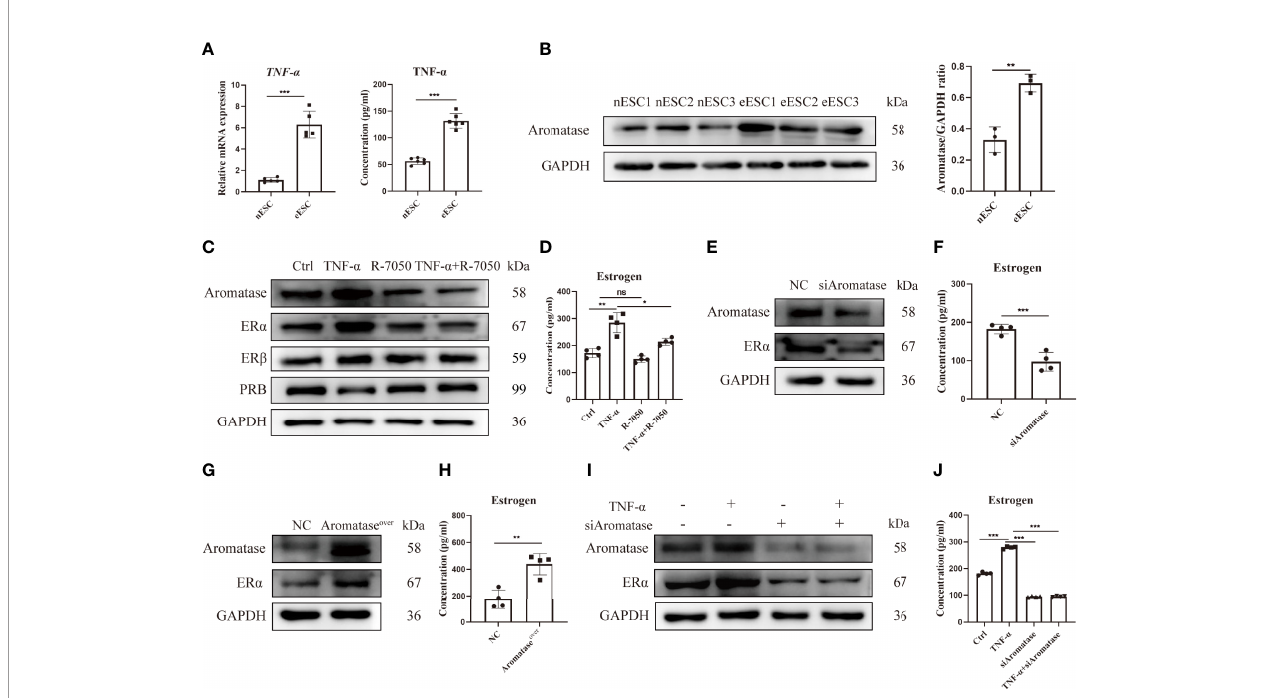
FIGURE 5 | TNF- a promotes an imbalance of estrogen and progesterone signaling in eESCs. (A) The mRNA expression (n = 5) and concentration (n = 6) of TNF- a in eESCs and nESCs were detected via RT-PCR and ELISA. (B) The aromatase expression of eESCs and nESCs was detected via Western blotting (n = 3). (C, D) After treatment with TNF- a (10 ng/ml), R-7050 (5 µM), or TNF- a +R-7050 (10 ng/ml, 5 µM), the expressions of aromatase, ER a , Er b , and PRB in eESCs were analyzed via Western blotting (C) , and the concentration of estrogen was detected via ELISA (n = 4) (D) . (E – H) Aromatase was silenced or overexpressed in eESCs for 48 h. Then, the expressions of aromatase and ER a were detected via Western blotting (E, G) , and the level of estrogen was assayed via ELISA (n = 4) (F, H) . (I, J) The protein expressions of aromatase and ER a were analyzed via Western blotting (I) , and the concentration of estrogen was detected via ELISA (n = 4) (J) . Continuous data are presented as the mean ± SD (* P < 0.05, ** P < 0.01, and *** P < 0.001; ns, not signi fi